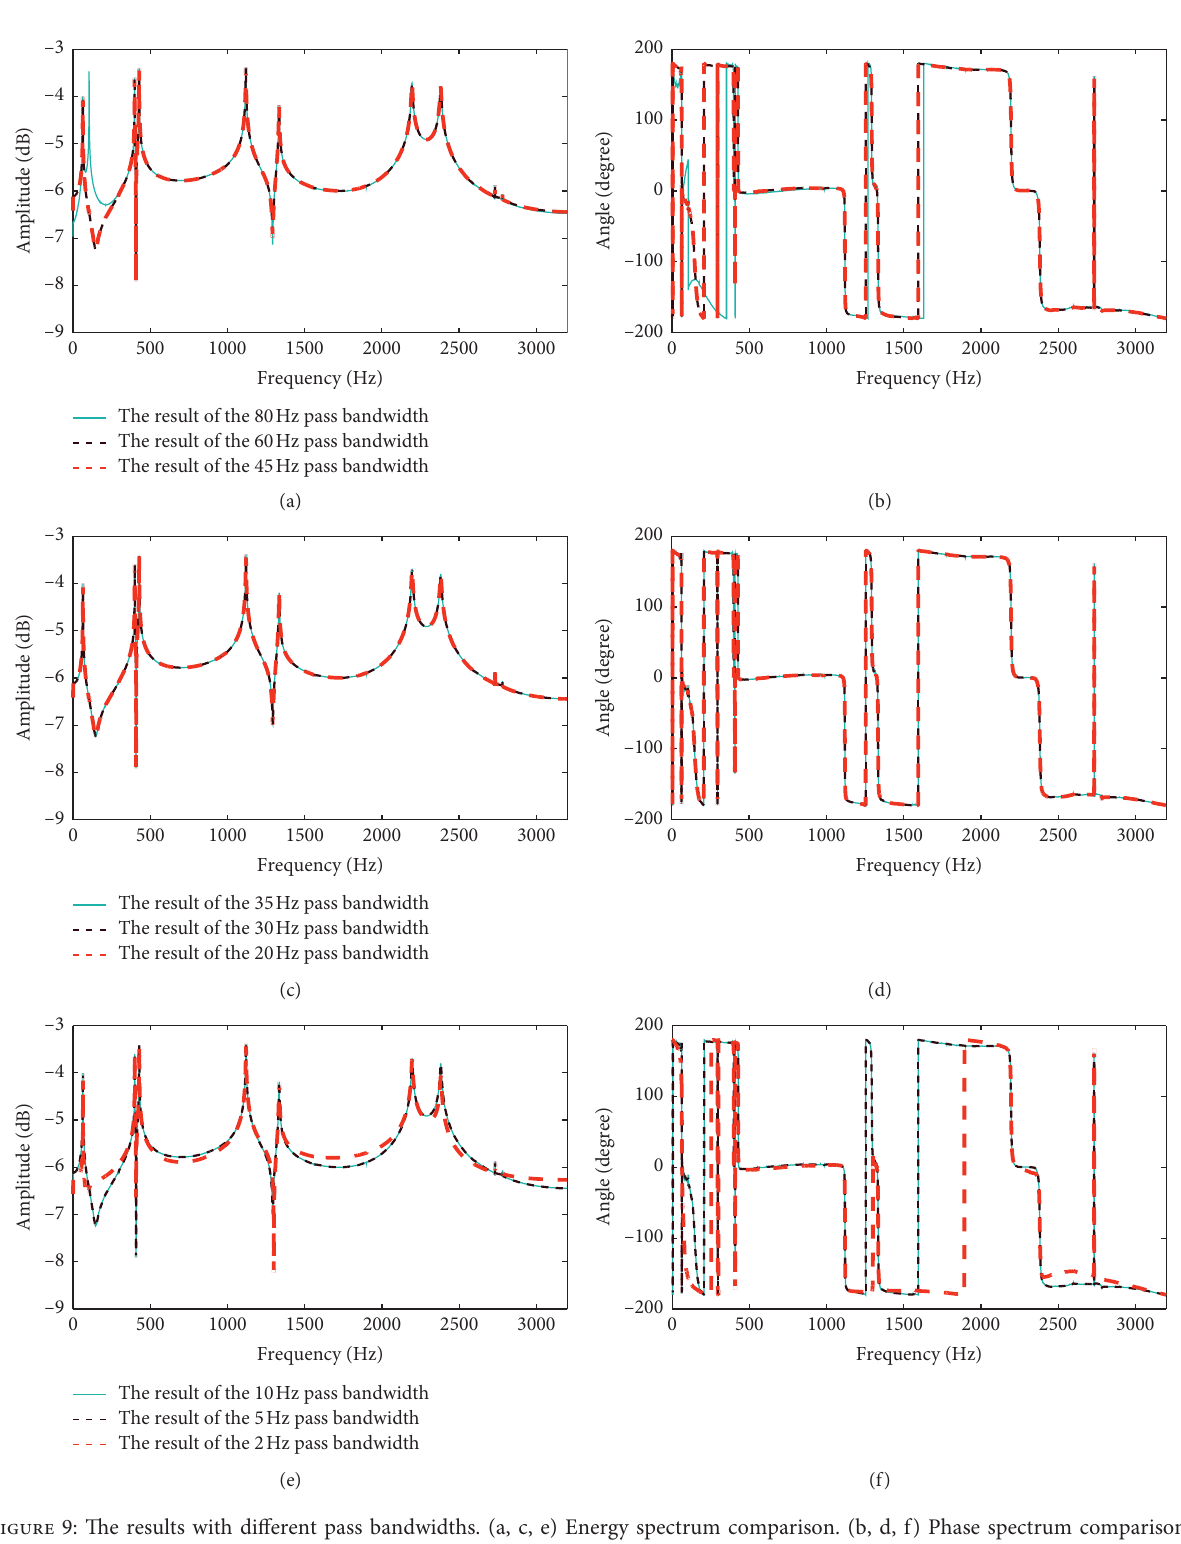
Figure 9: The results with different pass bandwidths. (a, c, e) Energy spectrum comparison. (b, d, f) Phase spectrum